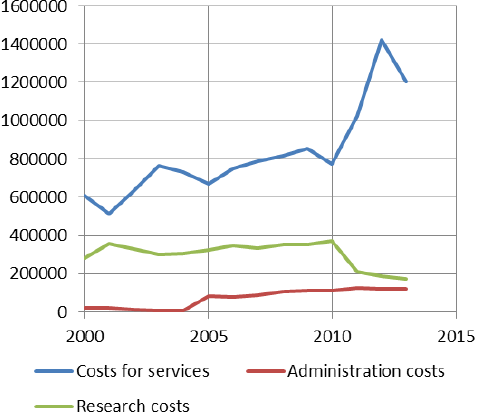
Figure 2: Composition of SKB production system 2000-2013